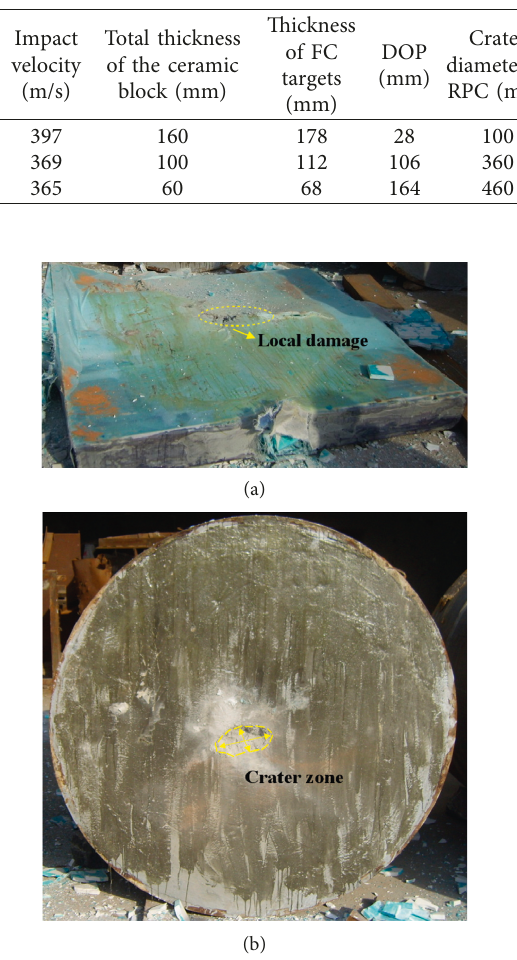
Figure 13: Damage results of FC-RPC target 1: (a) damage of the FC target; (b) damage of the RPC